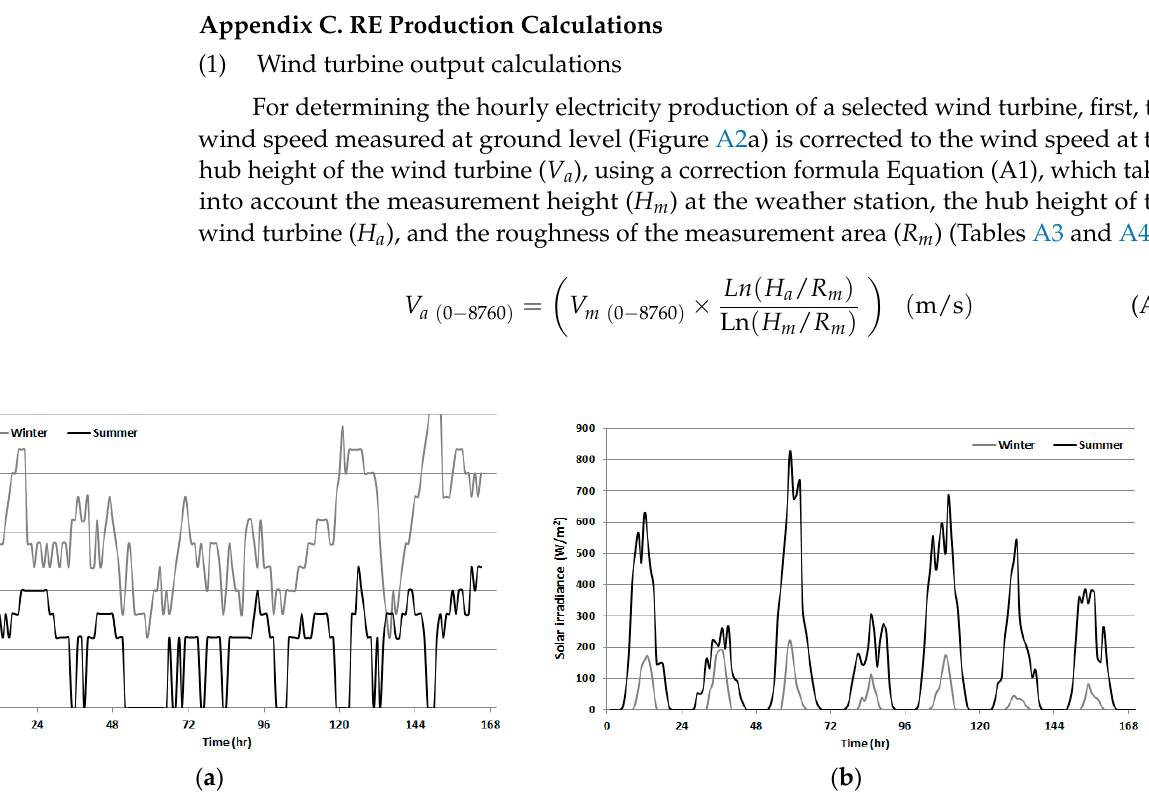
Figure A2. ( a ) Wind speed adjusted for hub height, winter and summer week. ( b ) Solar irradiance ground, winter and summer week. Table A5. Values used for wind correction formula.